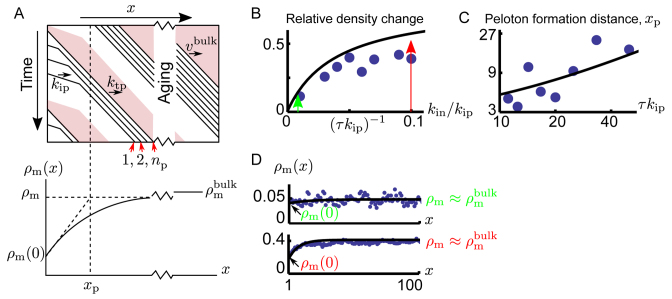
Peloton formation close to the initiation site. (A) The upper panel shows a schematic kymograph showing motors (black lines) initially not interacting with each other, until they reach the growing peloton. Motors initiate from the left and then travel into the system, moving through roadblock depleted regions (white) and roadblock filled regions (pink). If a roadblock is deposited between two motor initiation events, the last motor propagates with rate ktp and otherwise with rate kip. After a typical distance xp, a peloton of size np is formed. In the lower panel we sketch how peloton formation influences the motor density along genes. Once pelotons have formed (x > xp) the density reaches ρm. Once formed, the pelotons continue to merge and split until the system reaches the density \documentclass[12pt]{minimal}
\usepackage{amsmath}
\usepackage{wasysym}
\usepackage{amsfonts}
\usepackage{amssymb}
\usepackage{amsbsy}
\usepackage{upgreek}
\usepackage{mathrsfs}
\setlength{\oddsidemargin}{-69pt}
\begin{document}
}{}$\rho _{\rm m}^{\rm bulk}$\end{document}. Figures (B)–(D) show simulations and predictions for an open system with small roadblocks (δm = δrb = 1) such that τΔ ≈ τ for large roadblock binding times. (B) The dots are values for the relative change in motor density, (ρm − ρm(0))/ρm, from the start of the lattice to the point where all the initial pelotons have formed, obtained by fitting an exponential function to the motor density in the peloton forming region (estimated as the first 4xp lattice points) of simulated data. The line represents our theoretical predictions and the green and red arrows indicate the initiation rates used for Figure (D). (C) The distance xp over which pelotons form as a function of the roadblock equilibration time for kin/kip = 0.1. The dots are values for xp obtained by fitting an exponential distribution to the peloton forming region (estimated as the first 4xp lattice points) of simulated data, while the line represents our theoretical predictions. (D) Motor density profiles for τkip = 20, and kin/kip = 0.01 < (τkip)−1 in the top panel, and kin/kip = 0.1 > (τkip)−1 for the lower panel. Blue dots are the result of Monte Carlo simulations and black lines are our analytical predictions. Note, there are no free parameters in any of the analytical predictions in (B)–(D).